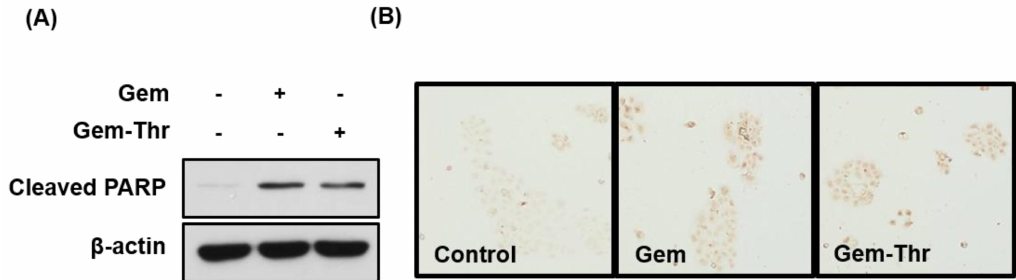
Figure 4. Apoptosis of pancreatic cancer cells by Gemcitabine derivative. After the treatment of gemcitabine and Gem-Thr to BxPC-3 cells for 24 h, cleaved PARP was detected by western blotting ( A ) and TUNEL assay ( B ) was